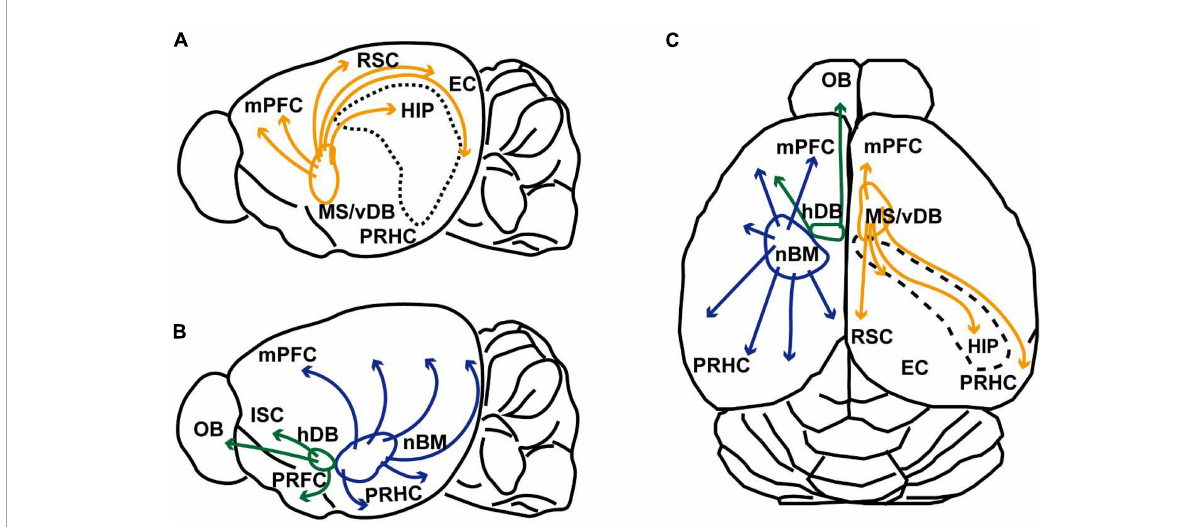
FIGURE1 Schematic illustrations of cholinergic innervation from the basal forebrain of rodent. (A) Schematic sagittal view of the rodent brain illustrating cholinergic projection from the medial septum and ventral diagonal band of Broca (MS/vDB) to the medial prefrontal cortex (mPFC), retrosplenial cortex (RSC), entorhinal cortex (EC), hippocampus (HIP, and perirhinal/postrhinal cortices (PRHC). Cholinergic projections are indicated by orange lines. (B) Schematic sagittal view of the rodent brain showing cholinergic projection from the horizontal diagonal band of Broca (hDB) and nucleus basalis magnocellularis (nBM). Cholinergic neurons in the hDB innervates the olfactory bulb (OB), insular cortex (ISC) and piriform cortex (PRFC). Cholinergic neurons in the nBM project to the entire cortex including the mPFC and PRHC. Cholinergic modulations are indicated green and blue lines. Projections to the amygdala are omitted from the illustration. (C) Schematic dorsal view of the rodent cholinergic system. The right hemisphere shows cholinergic innervation from the MS/vDB. The left hemisphere indicates cholinergic projections from the hDB and